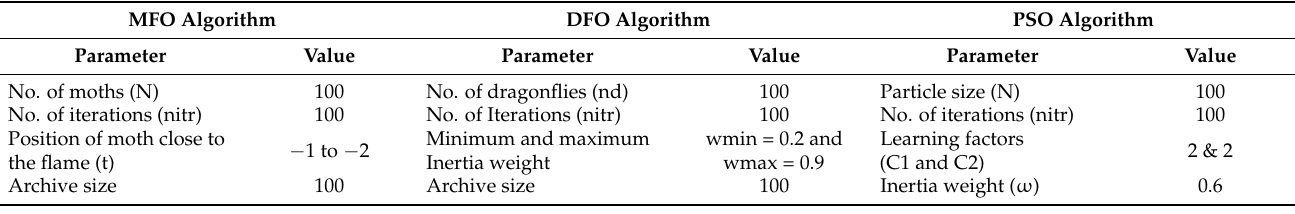
Algorithm 1: MFO